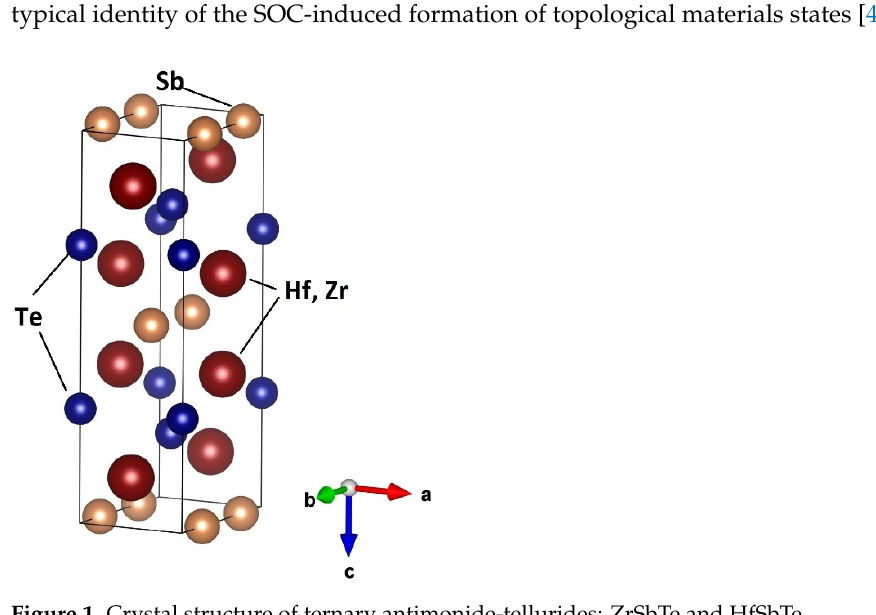
Figure 1. Crystal structure of ternary antimonide-tellurides: ZrSbTe and HfSbTe.